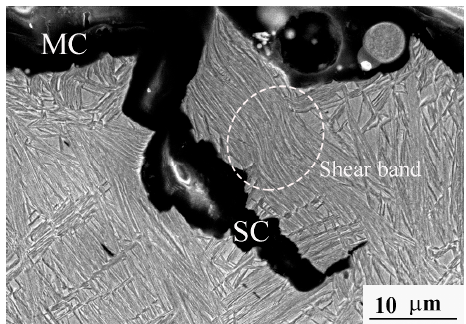
Figure 8. SEM fractograph of microstructure near main crack ( MC ) and secondary crack ( SC ) fracture surfaces of the A2 sample following fatigue break at maximum stress of 1.3 GPa and 49,168 cycles.